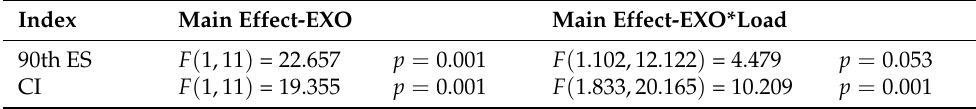
Table 3. Summary of the statistical analysis of the exoskeleton effect for the 30 ◦ trunk